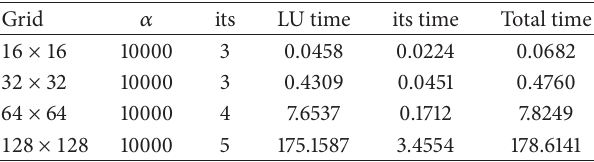
Table 1: Preconditioned GMRES(20) on Stokes problems with different grid sizes (uniform grids).